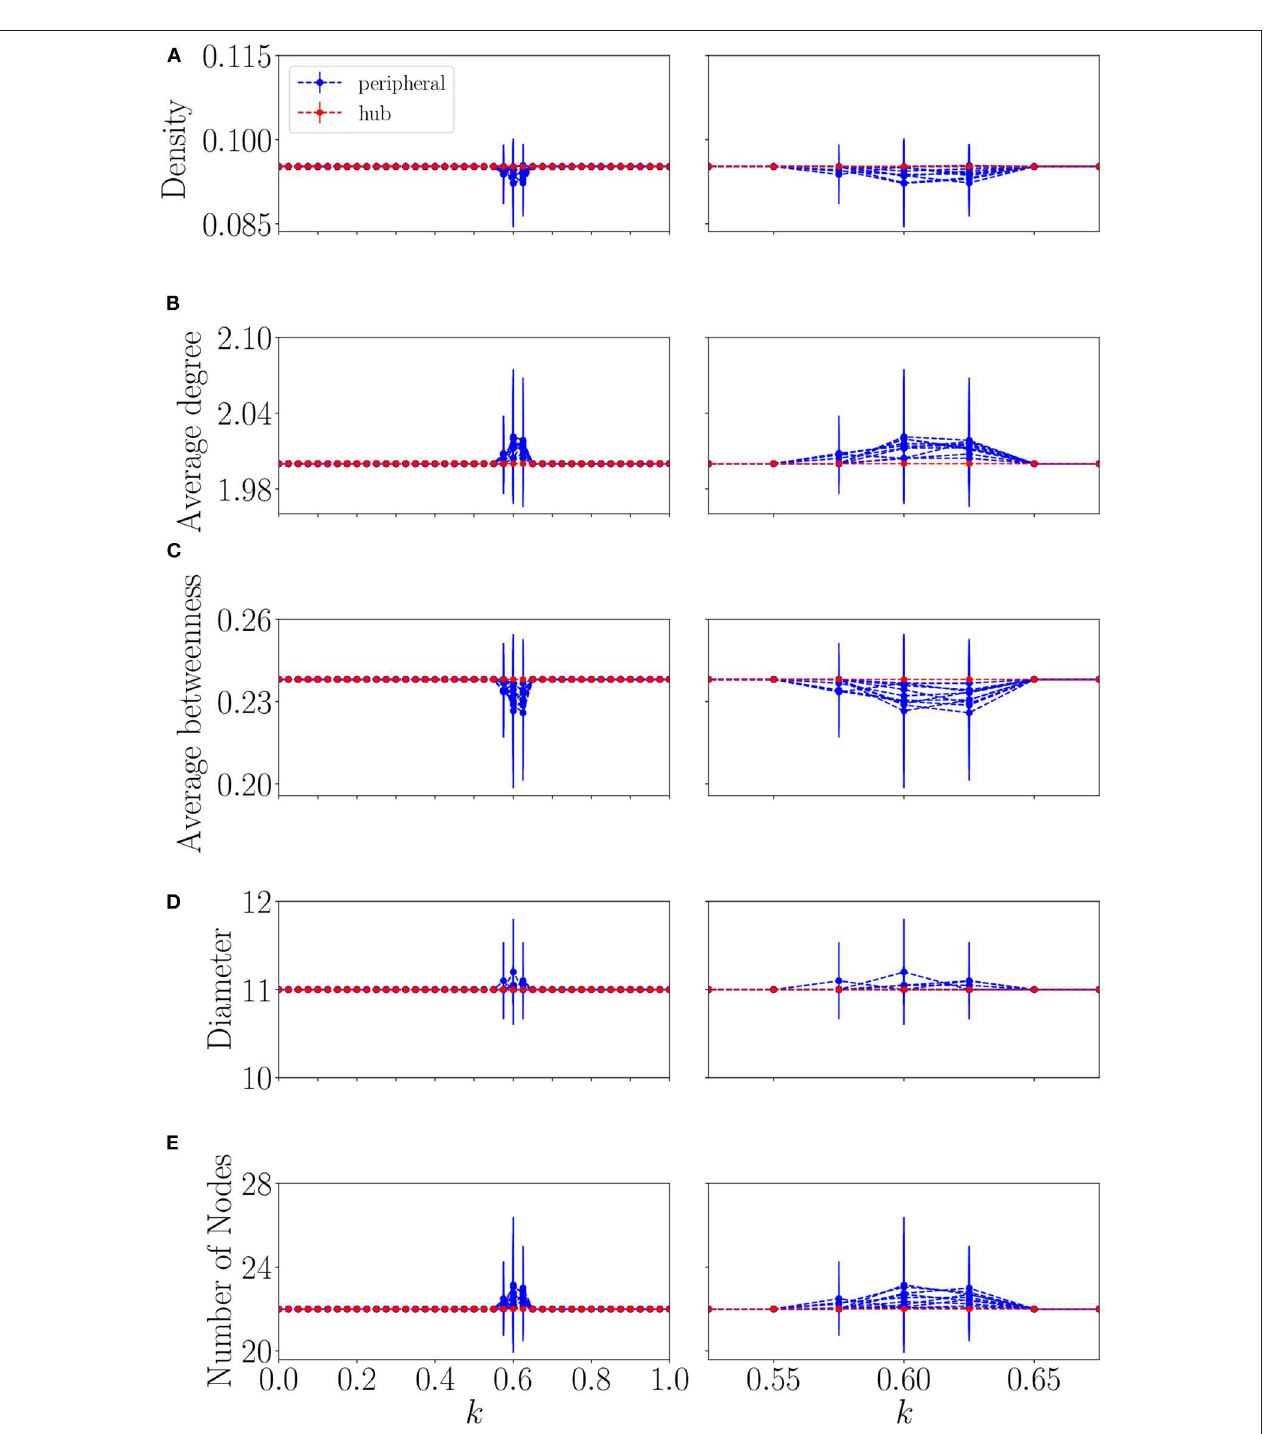
FIGURE 6 | Network 1. Mean and standard deviation of the network metrics (A) density, (B) average degree, (C) average betweenness, (D) diameter, and (E) average number of nodes as a function of coupling k . The plots on the right column are amplifications of the ones on the left. Values of metrics related to the peripheral nodes are in blue and related to the hub are in